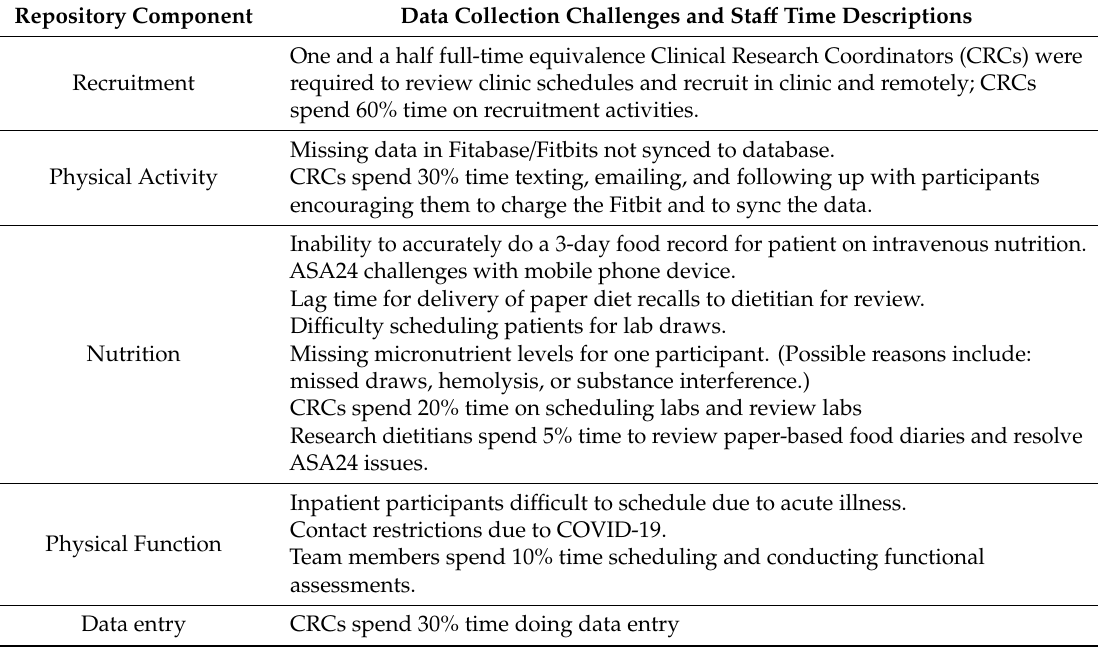
Table 4. Feasibility: resources and logistics including time usage for 1.5 full-time Clinical Research Coordinators